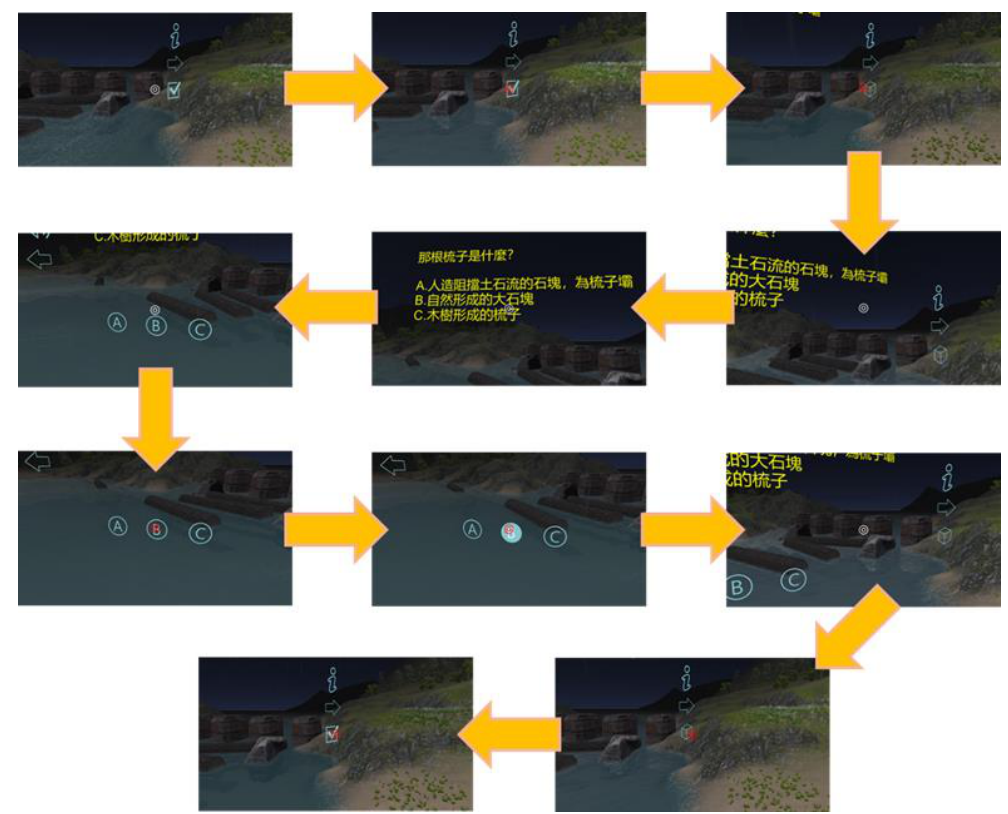
Figure 10. The procedure of displaying single choice questions first and then selecting an answer to questions.